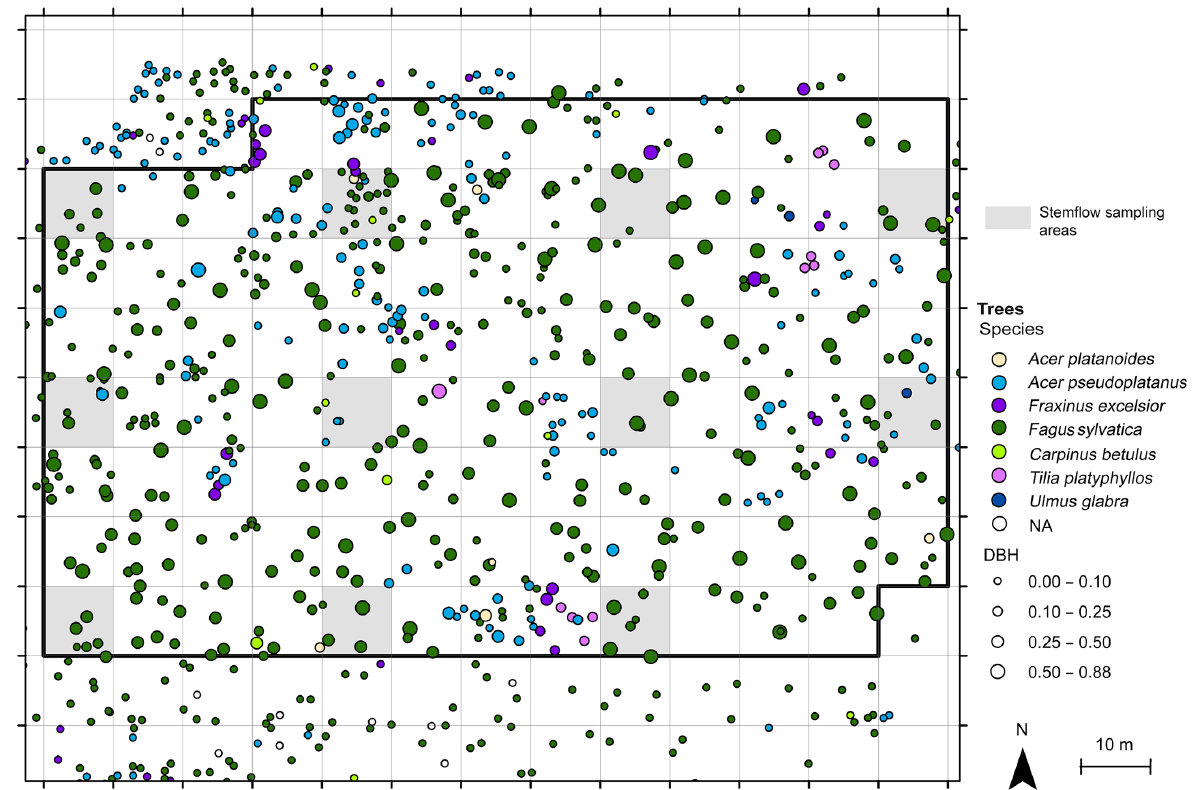
Figure 1. Position of the 11 subplots (grey shaded areas, 10m × 10m) in which stemflow was sampled within the forest